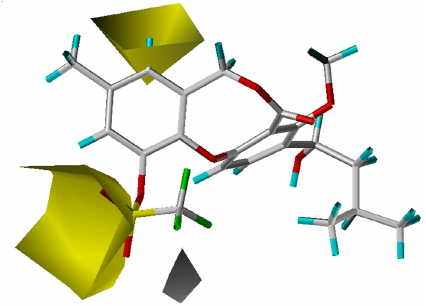
Figure 3. Hydrophobic maps from the CoMSIA model. Compound 63 is shown inside the field. The two yellow areas (contour level 0.02) suggest that hydrophobic substituents will result in an increase in activity, while the white region (contour level -0.01) suggests that a corresponding decrease will